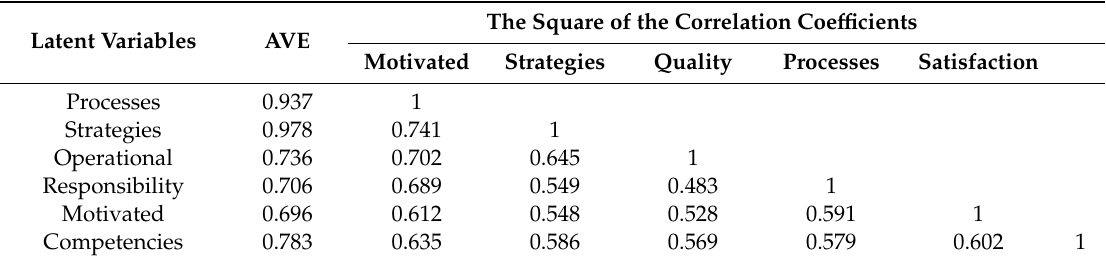
Table 6. Correlation coe ffi cients among the latent